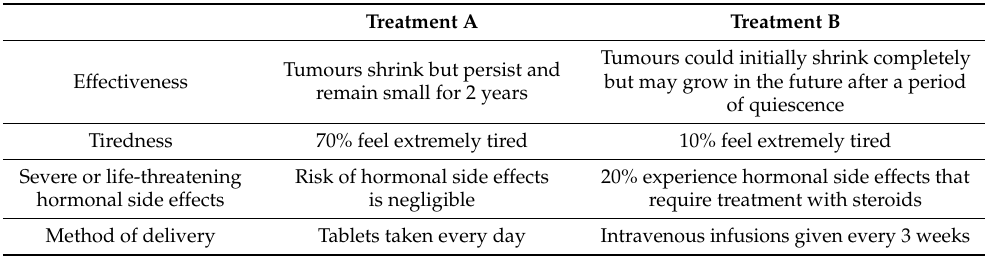
Table 2. Example choice set in a discrete choice experiment comparing 2 hypothetical treatment options for kidney cancer